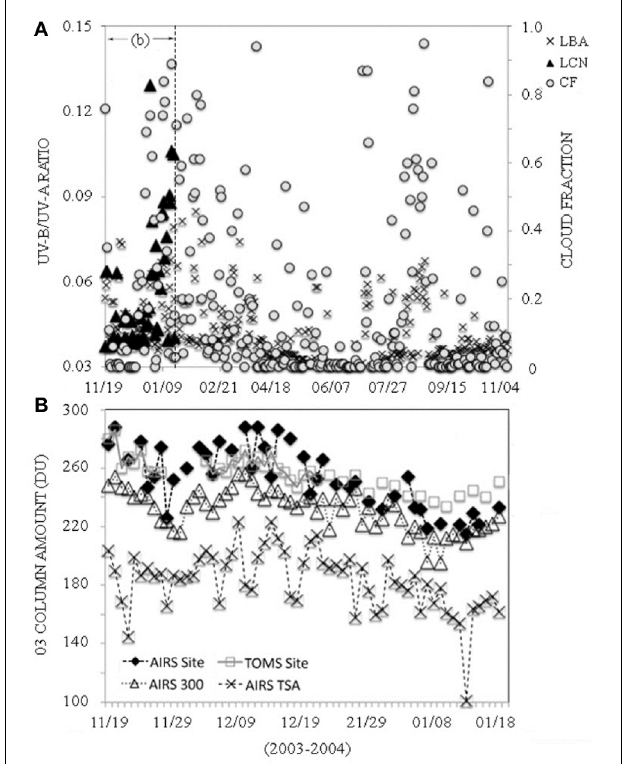
FIGURE 2 | UV-B/UV-A ratio daily maxima. (A) The highest values were consistently associated with increased cloud fraction; (B) ozone depletion, and NOAs. Ozone data are from the Aqua Atmospheric Infrared Sounder (AIRS), and the Earth Probe—Total Ozone Mapping Spectrometer (TOMS) instruments. The cloud fraction (CF) is from AIRS. AIRS (Site) gives the daily O 3 average over Licancabur (LCN) and Laguna Blanca (LBA) during the 61 days overlap of the two instruments. TOMS Site shows data over a 1 . 0 × 1 . 25 ◦ cell, and AIRS (300km) and TSA (Tropical South America) are the daily minimum O 3 value within 300km of Licancabur and over the tropical South